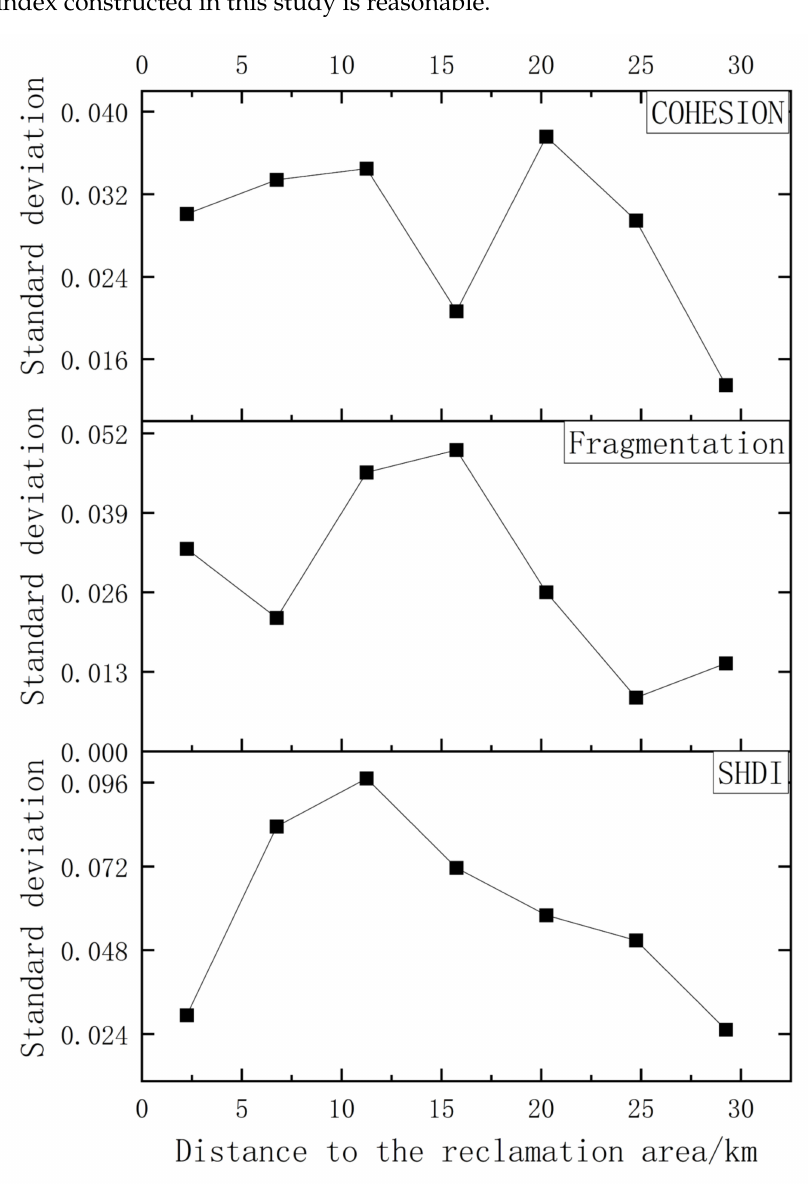
Figure 8. Standard deviation of the landscape pattern indices in different buffer